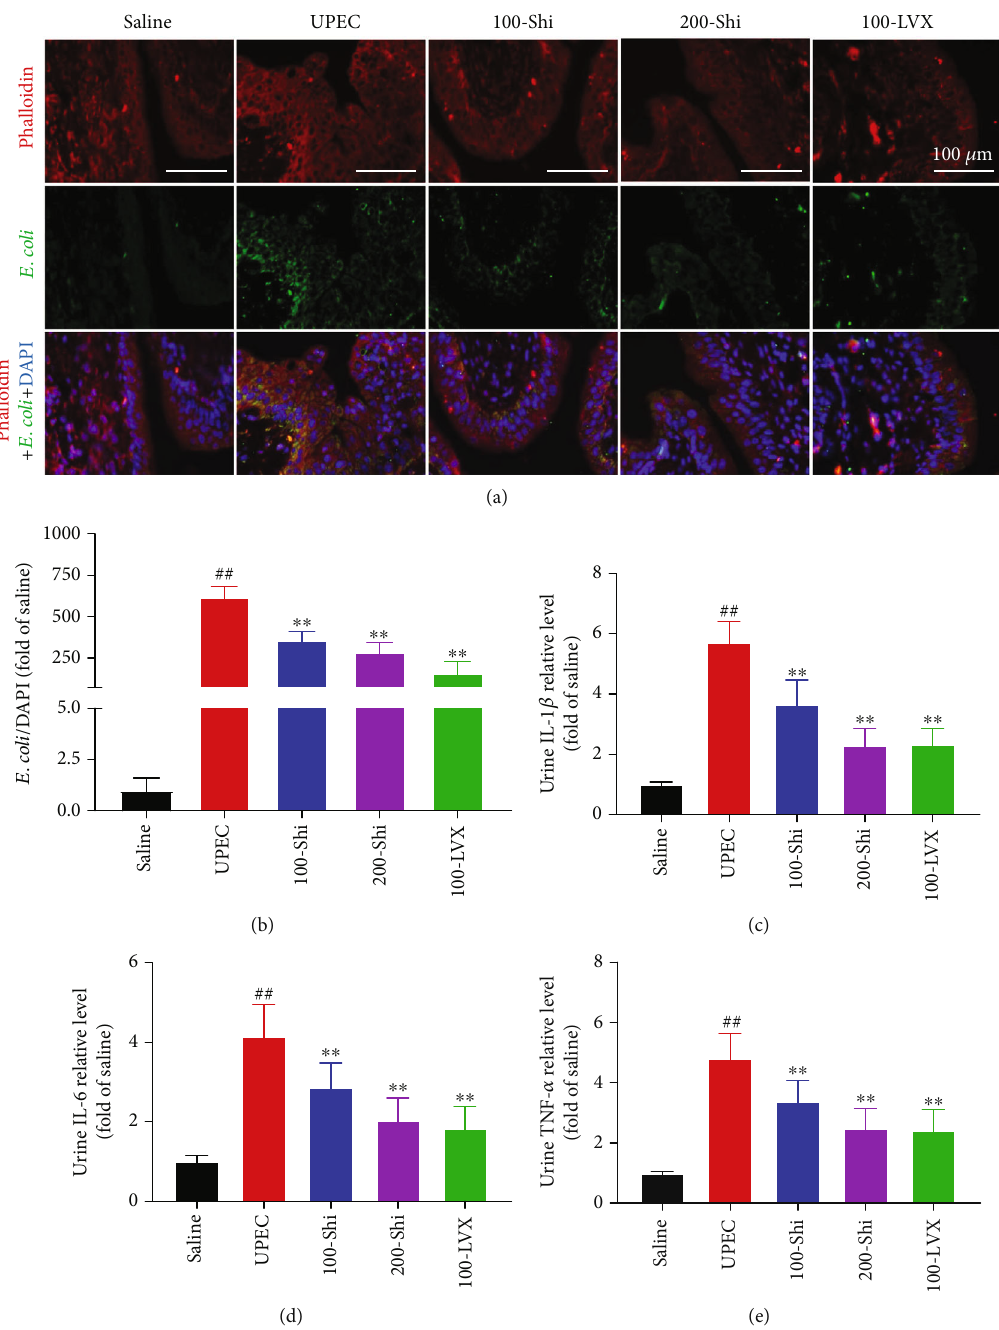
Figure 3: Shionone reduces E. coli and in fl ammation in the bladder of UTI rats. (a) Staining of cytoskeleton, E. coli , and nuclei in bladder tissue of each group of rats, with the cytoskeleton stained for phalloidin in red, E. coli in green, and nuclei stained for DAPI in blue. (b) Immuno fl uorescence intensity ratio of E. coli and DAPI. (c) The level of the in fl ammatory factor IL-1 β in the urine of rats in each group. (d) The level of the in fl ammatory factor IL-6 in the urine of rats in each group. (e) The level of the in fl ammatory factor TNF- α in the urine of rats in each group. Compared with the saline group, # means p < 0 : 05 and ## means p < 0 : 01 . Compared with the UPEC group, ∗ means p < 0 : 05 and ∗∗ means p < 0 : 01